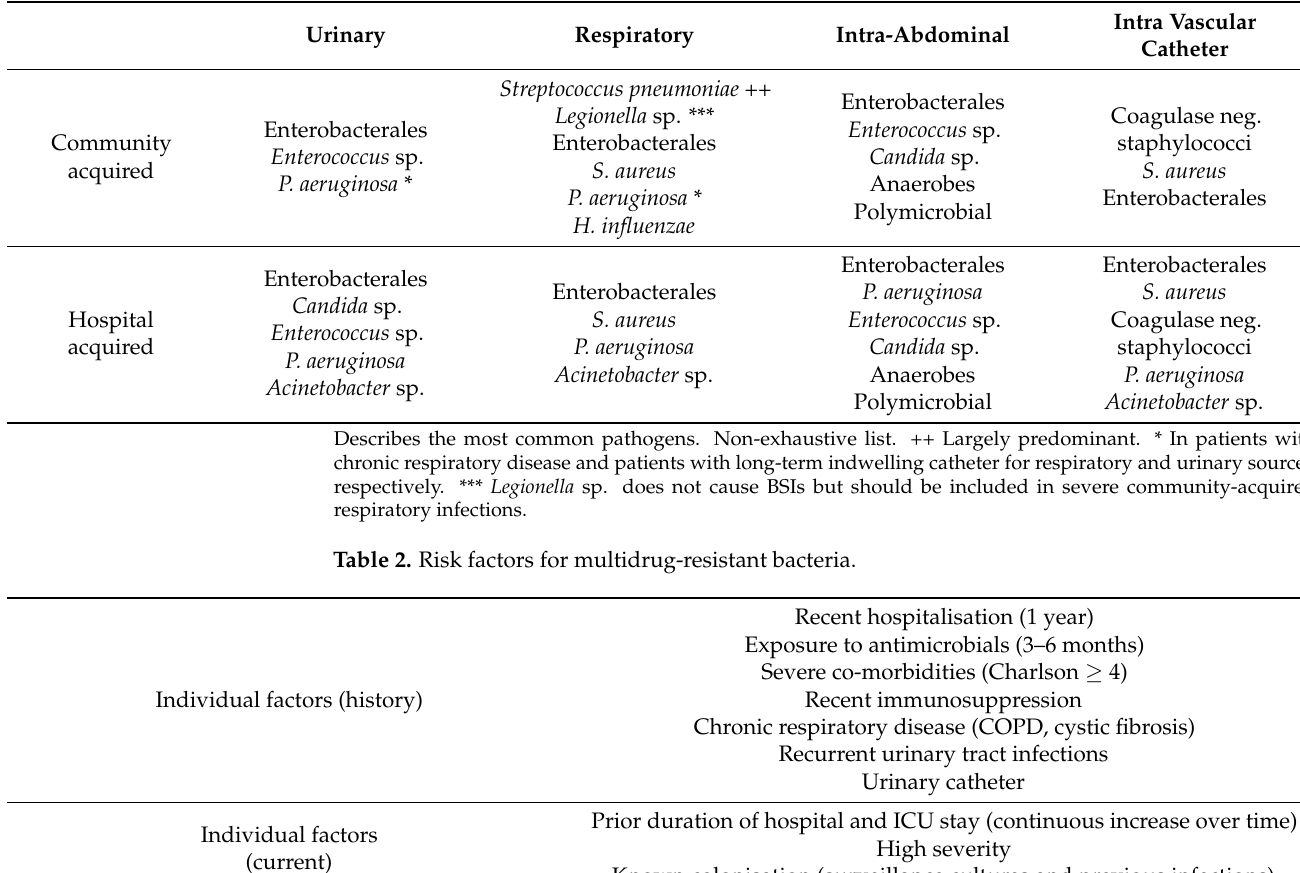
Table 1. Most common pathogen groups according to the presumed source of infection.